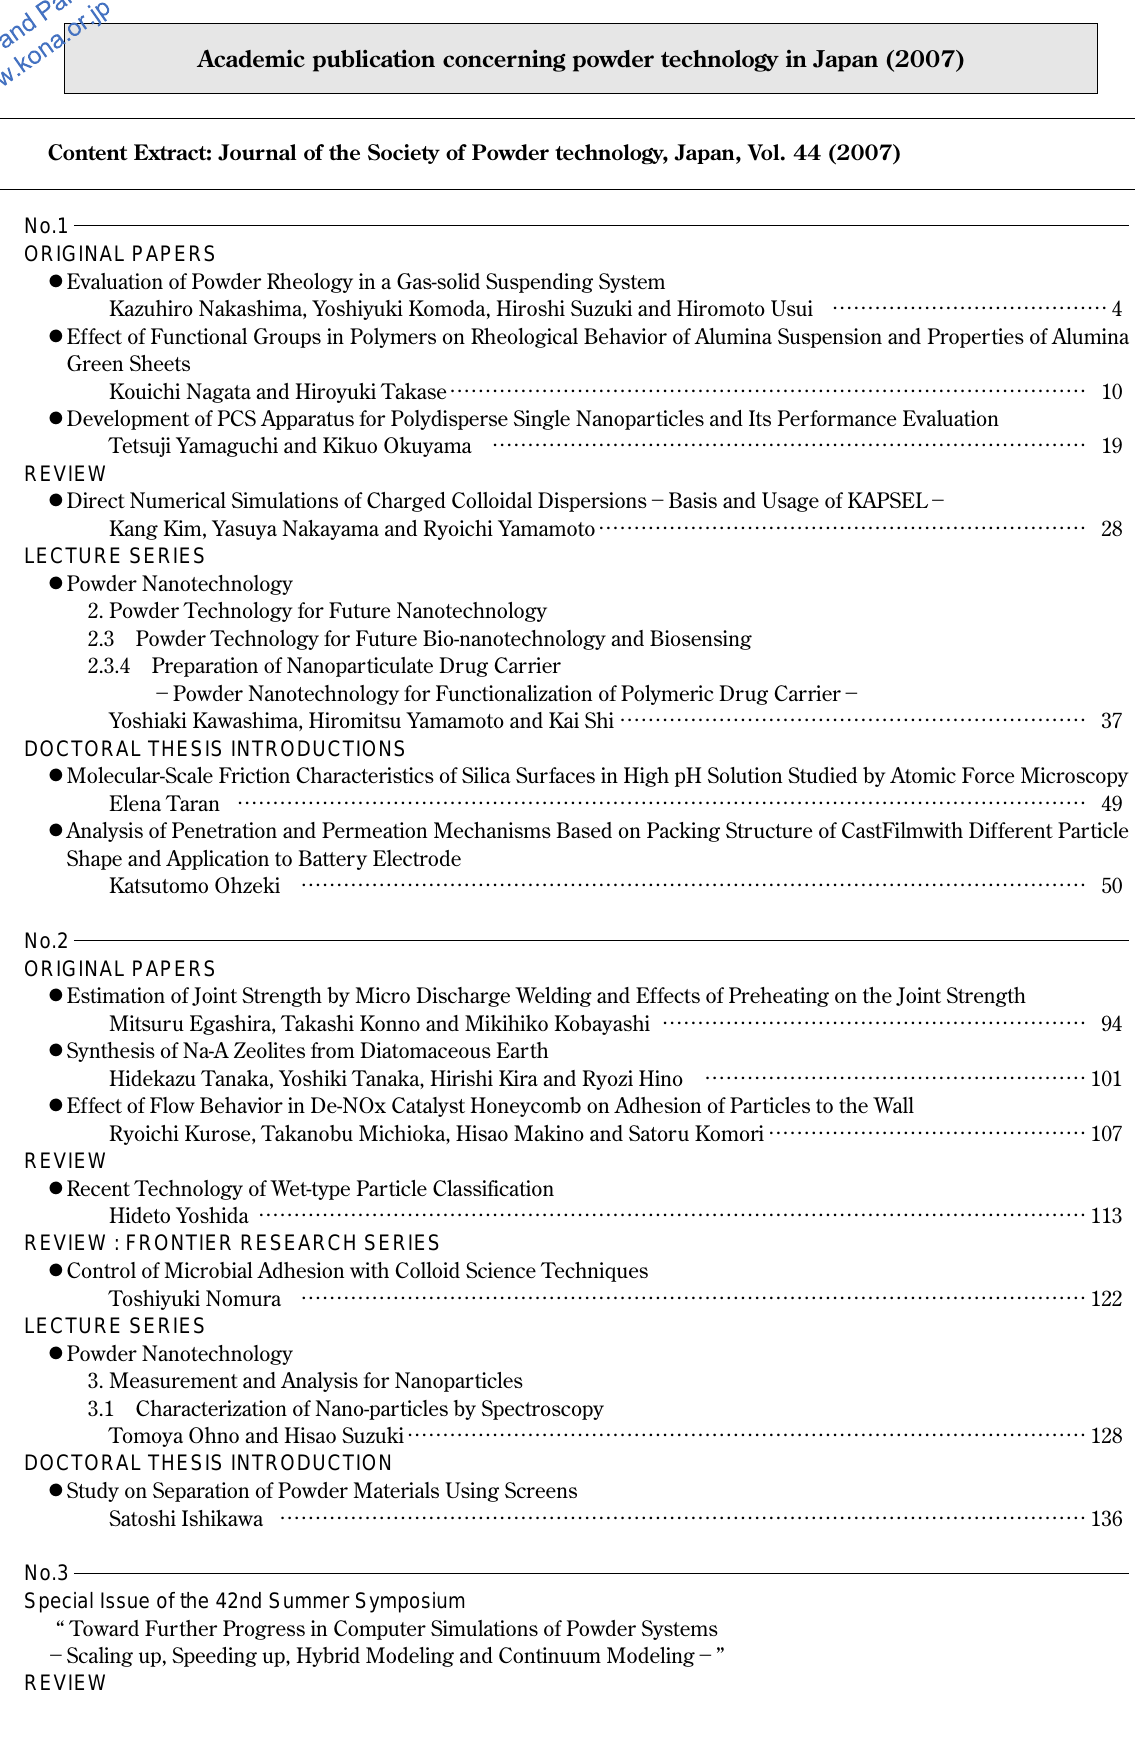
・ Evaluation of Powder Rheology in a Gas-solid Suspending System Kazuhiro Nakashima, Yoshiyuki Komoda, Hiroshi Suzuki and Hiromoto Usui ………………………………… 4 ・ Effect of Functional Groups in Polymers on Rheological Behavior of Alumina Suspension and Properties of Alumina Green Sheets ・ Development of PCS Apparatus for Polydisperse Single Nanoparticles and Its Performance Evaluation